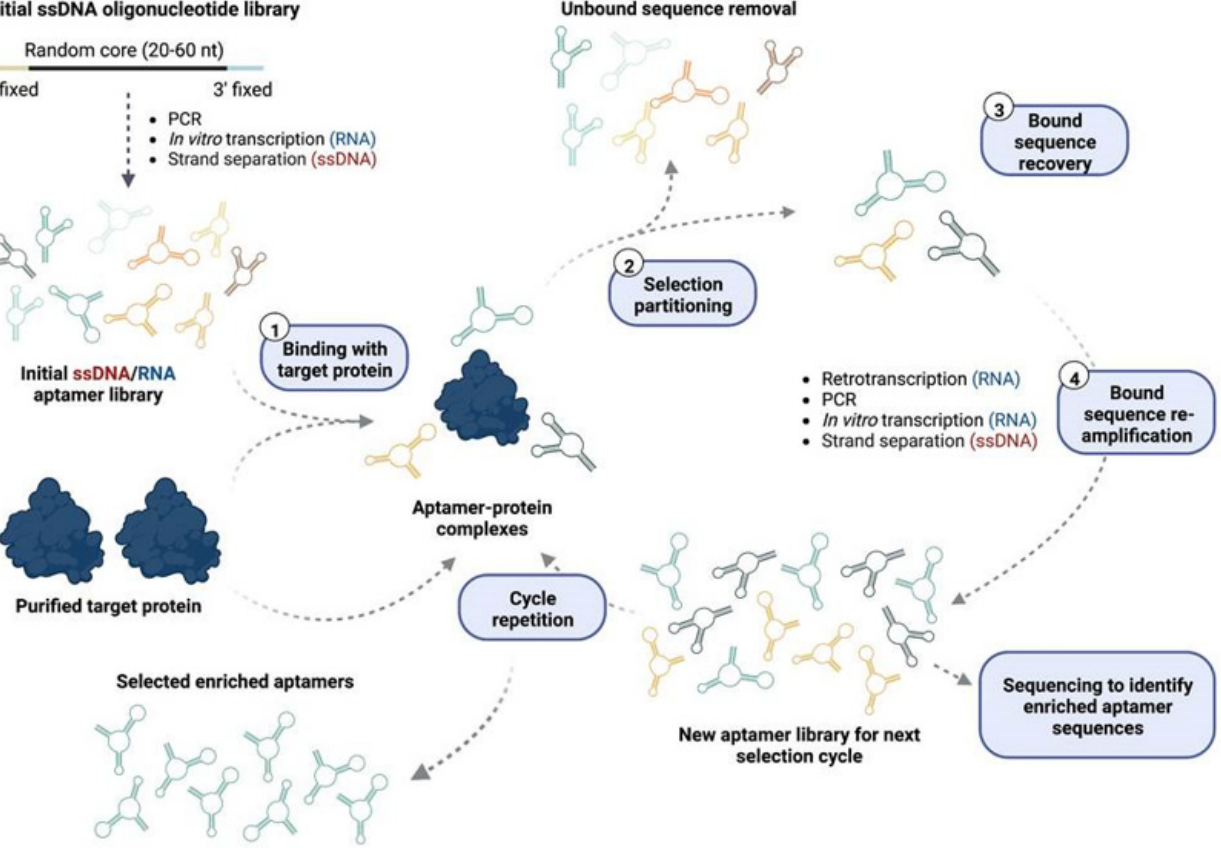
Figure 1. Overview of purified protein-based SELEX. The initial RNA/ssDNA aptamer pool is generated from a commercial ssDNA oligonucleotide library consisting of a central random core sequence flanked by fixed 5 ′ and 3 ′ primer binding regions to allow library amplification. To obtain RNA/ssDNA aptamers for the first selection cycle, the library is amplified by PCR and subjected to in vitro transcription or strand separation, respectively. A purified protein-based SELEX